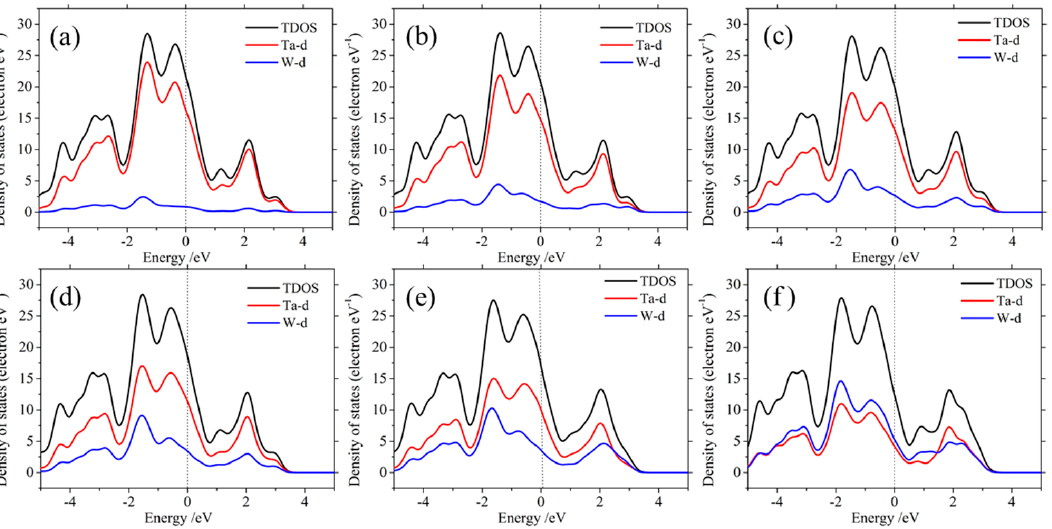
Figure 10. The partial density of states (PDOS) of Ta and W atoms in Ta–W alloys: ( a ) Ta–6.25W, ( b ) Ta–12.5W, ( c ) Ta–18.75W, ( d ) Ta–25.00W, ( e ) Ta–31.25W, ( f ) Ta–50.00W.